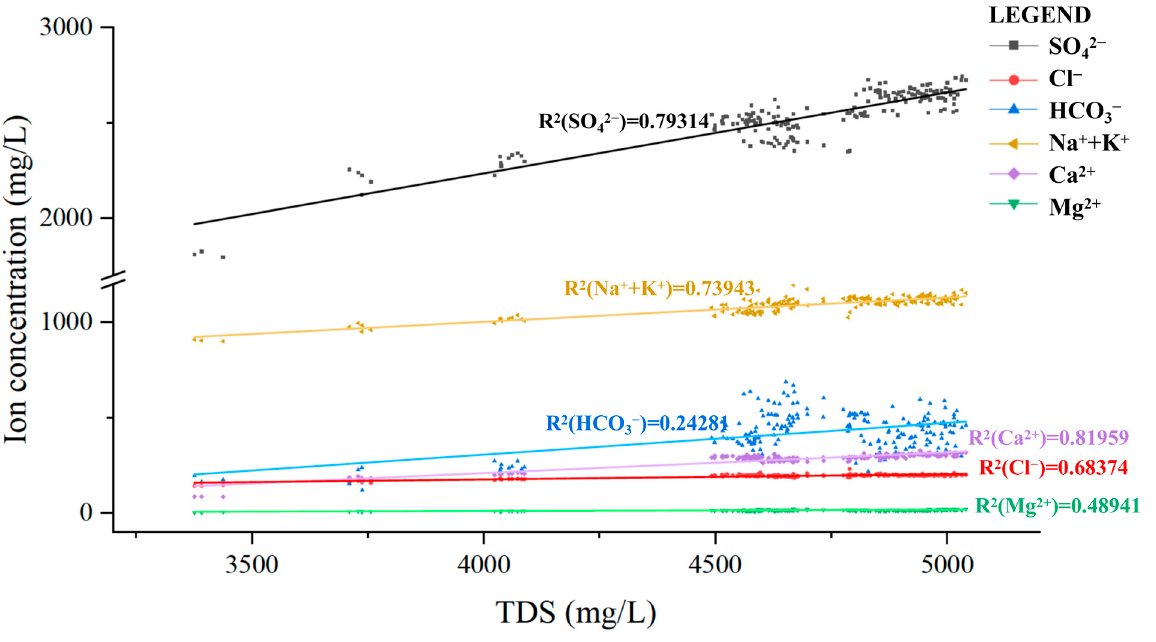
Figure 6. The relationship between TDS and ion concentration.